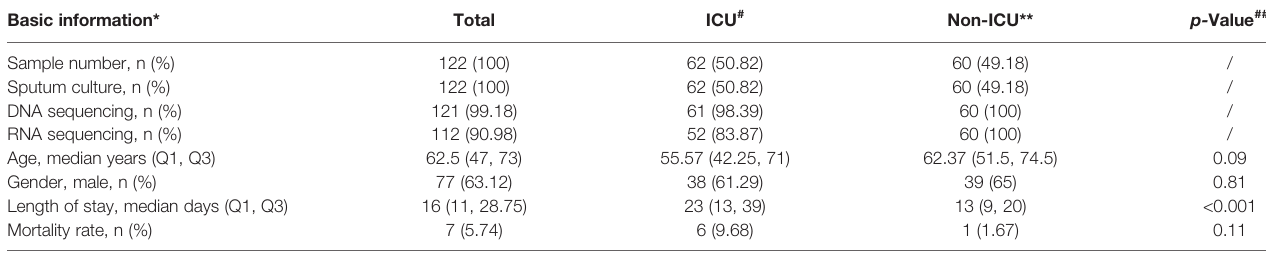
TABLE 1 | Basic information on samples and